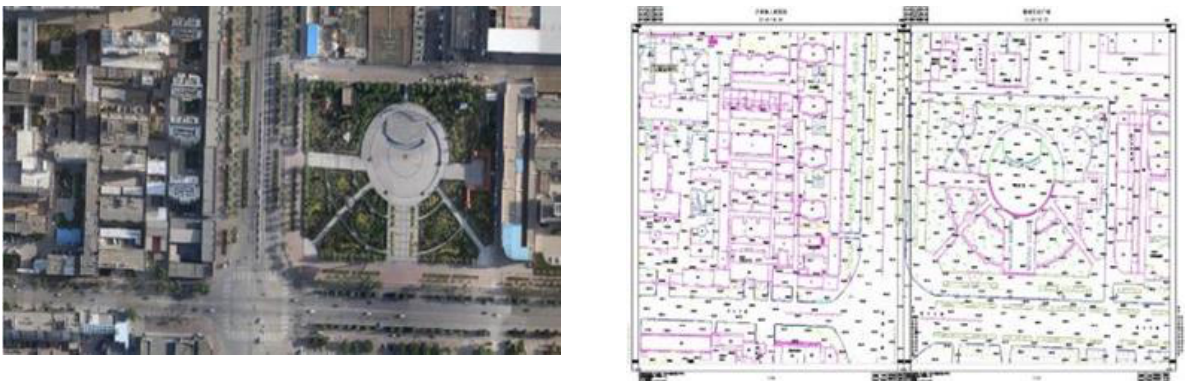
Figure 8. 1:500 DOM and DLG in study area